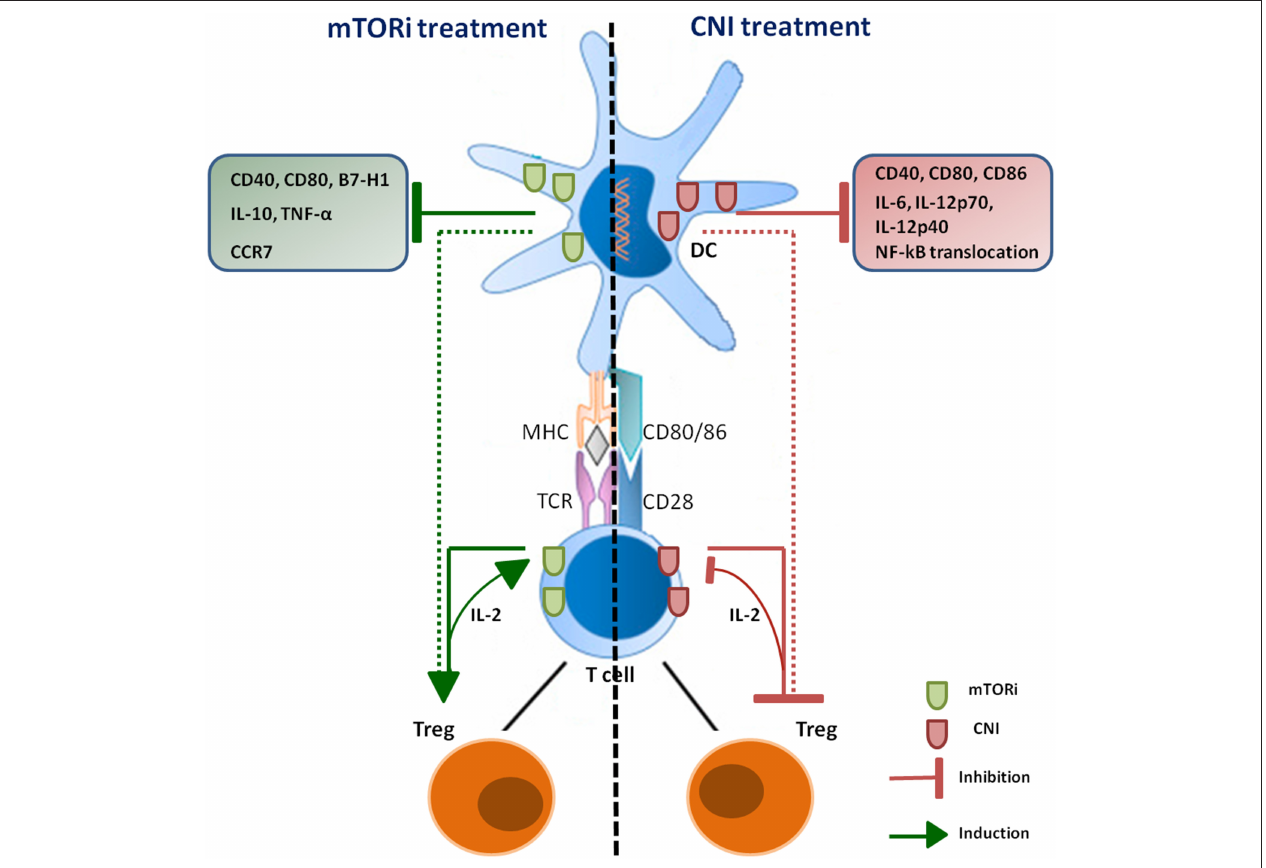
FIGURE 1 | Schematic overview of CNI and mTORi immunosuppressive effects on DCs and Treg. Immunosuppressive agents have opposite effects on Treg population through both direct and indirect mechanisms. DCs treated with CNI show a down-regulation of IL-2 and IL-12 production, which are necessary to induce Treg proliferation; CNI also direct inhibit production and re-uptake of IL-2 by T lymphocytes, impairing differentiation and proliferation of Treg. RAPA-DCs promote Treg proliferation and are able to induce the generation of this subset; mTORi can also direct stimulate induction of Treg, promoting organ transplantation